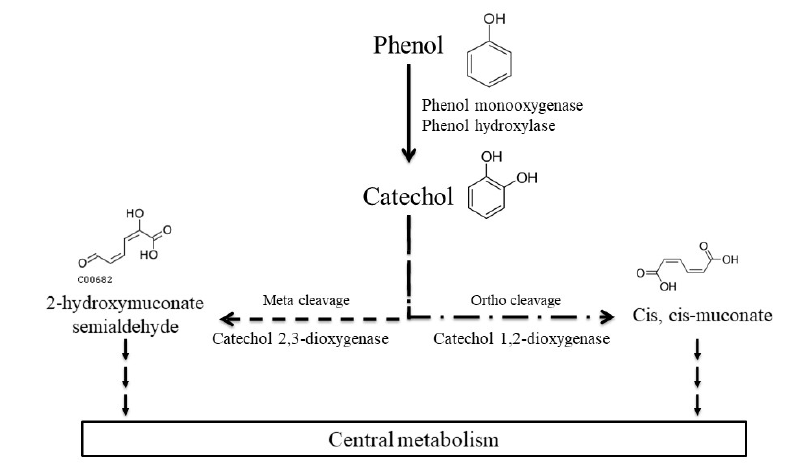
Figure 1. Main phenol biodegradation pathways described for aerobic microorganisms as referred to in the KEGG database.